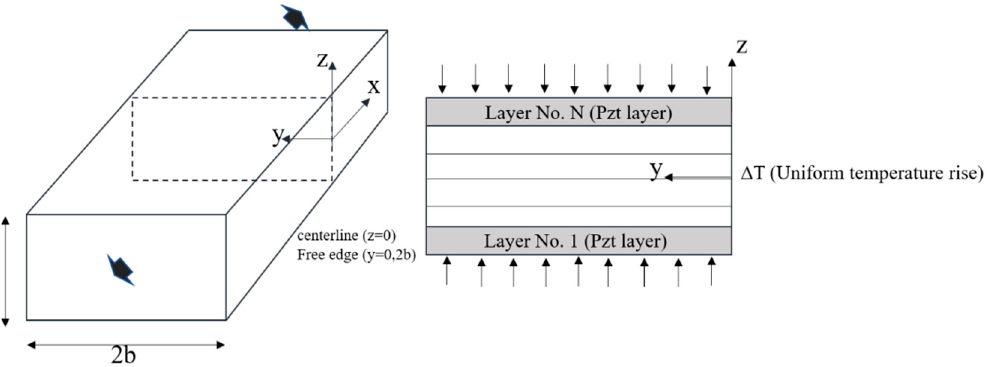
Figure 1. Configuration of the composite laminate under the combined extension, and the thermal ( ∆ T) and electric load.